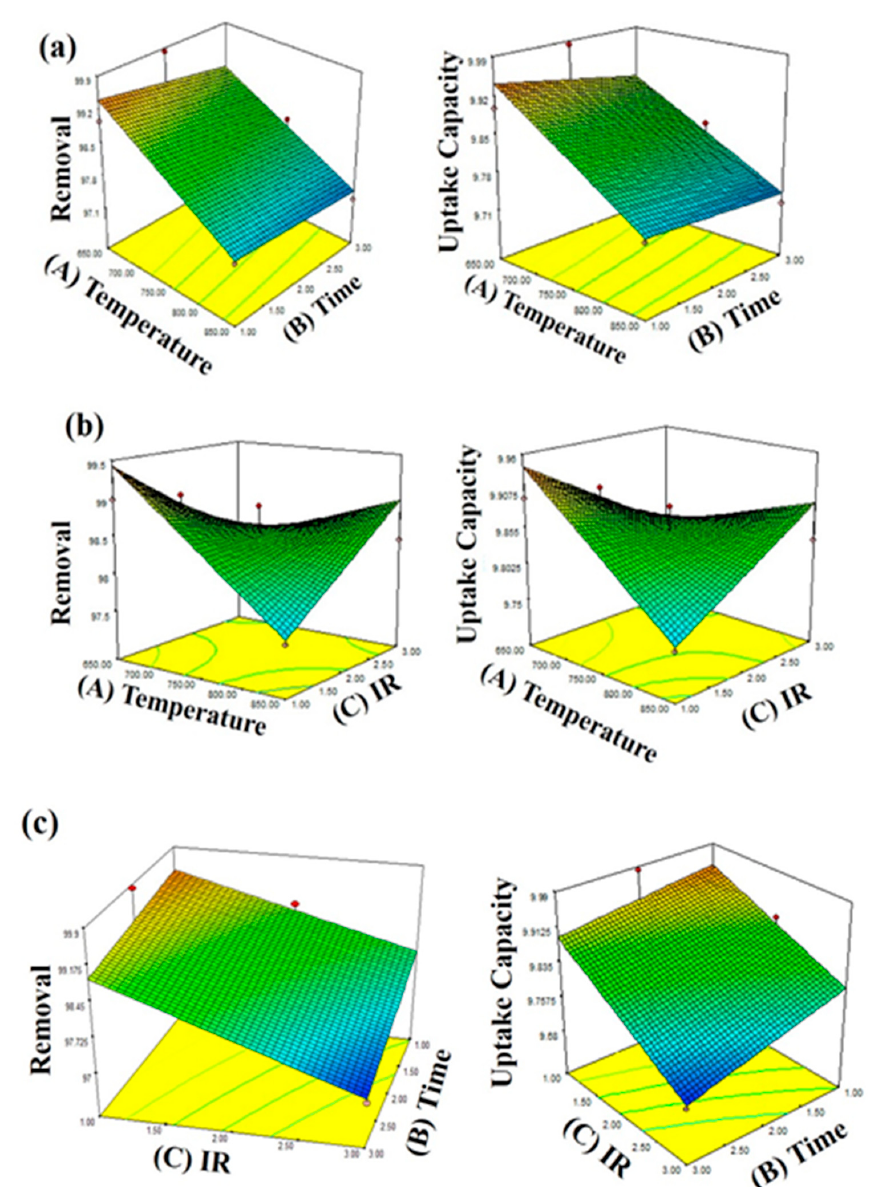
Figure 2. Surface response plots for the e ff ects of ( a ) activation temperature and impregnation ratio ( b ) activation temperature and activation time ( c ) impregnation ratio and activation time, on removal (%) and uptake capacity (mg · g − 1